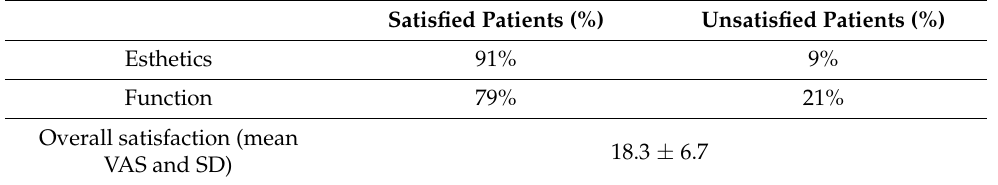
Table 6. Overall patient